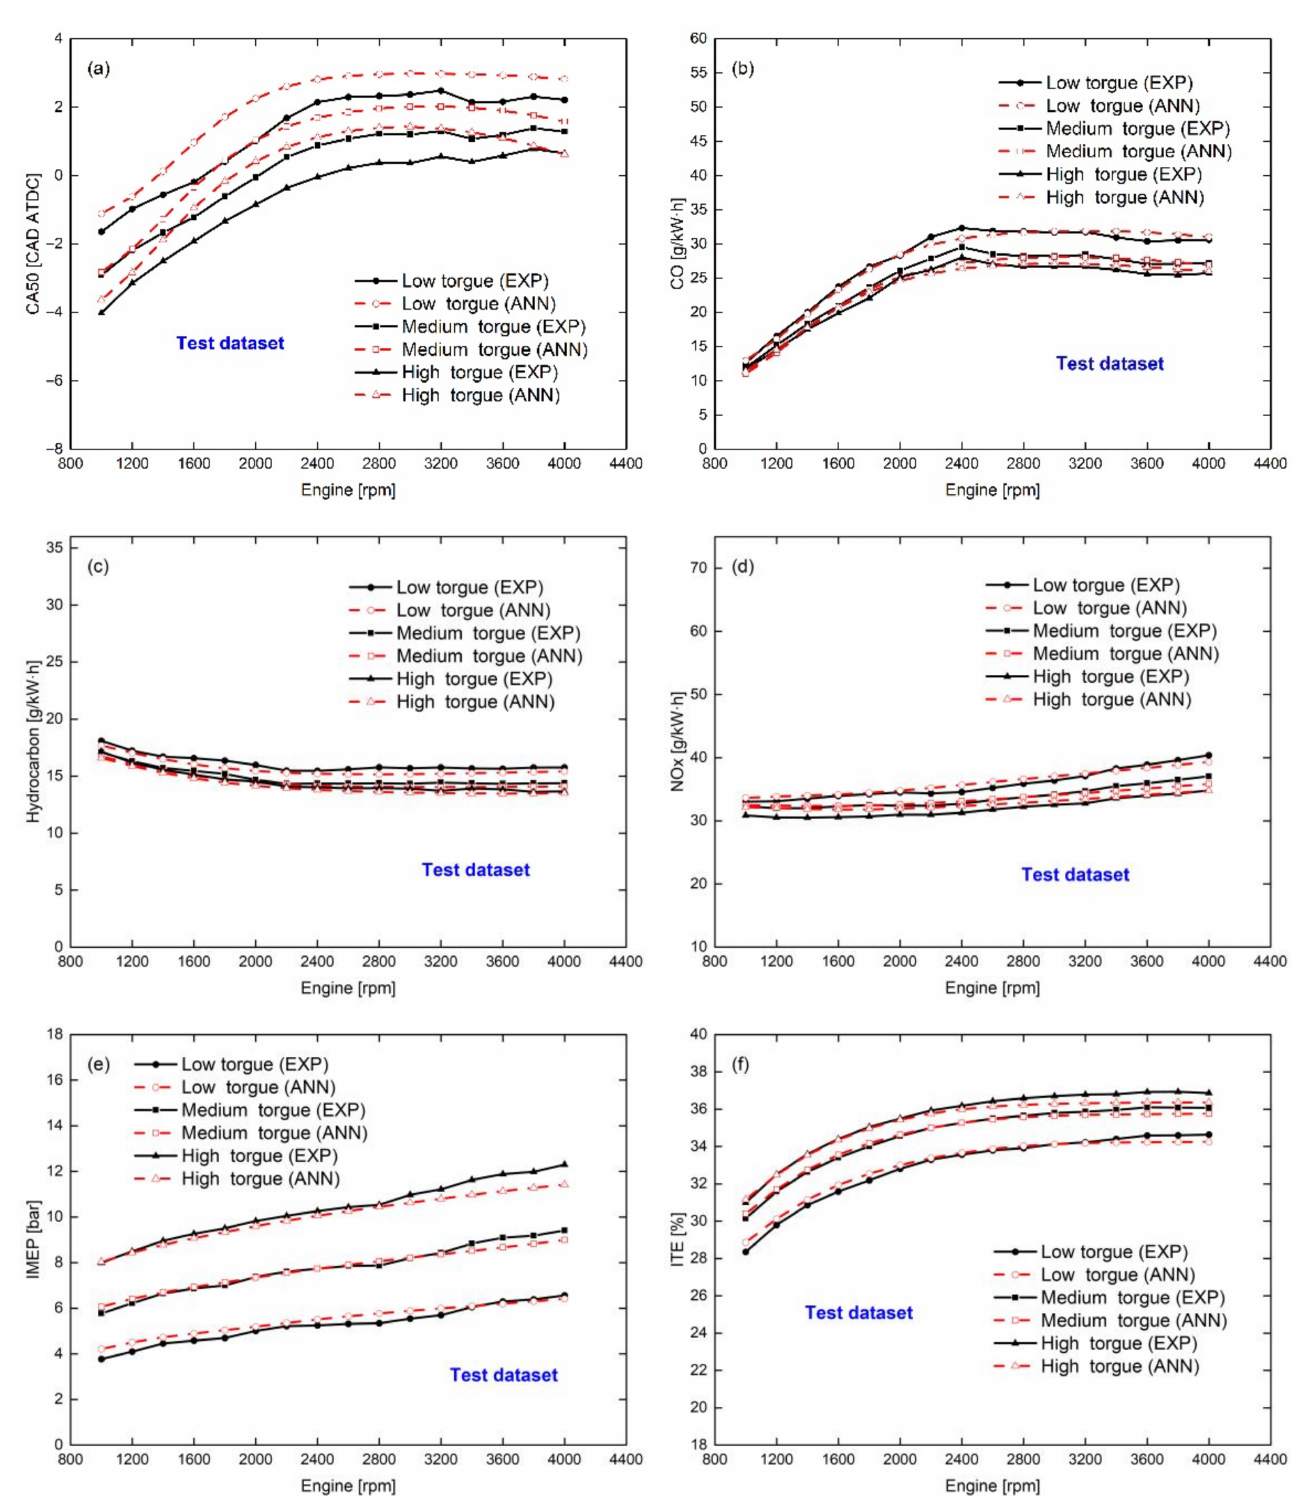
Figure 8. Comparison of ANN model predicted performance and emissions with calibrated data at the spark timing = − 20 CA ATDC for the steady test dataset: speed effects: ( a ) CA50, ( b ) CO, ( c ) UHC, ( d ) NOx, ( e ) IMEP, ( f )